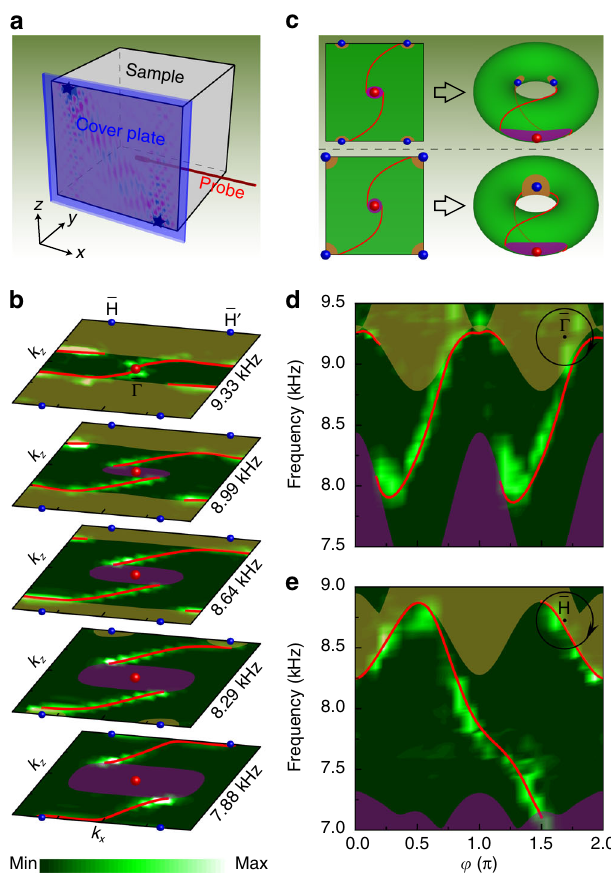
Fig. 4 Experimental evidence for the double-helicoid surface arcs around (cid:1) Γ . a Experimental setup for surface measurements. b 2D Fourier transformations (color scale) of the measured surface fi elds at different frequencies, compared with the numerical isofrequency contours of the topological surface states (red lines). As before, the color spheres highlight the projected Weyl nodes, and the shaded areas are the projected bulk bands. c Schematic illustration of the surface arc connectivity between one charge-2 QWP and two charge-1 CWPs in our system (top), compared with that between the spin-1 Weyl point and charge-2 Dirac point in recent studies 12,29 (bottom). d Surface spectrum extracted along the loop of radius 0 : 5 π = a centered at (cid:1) Γ . e Surface spectrum extracted along the loop of radius 0 : 43 π = a centered at (cid:1)